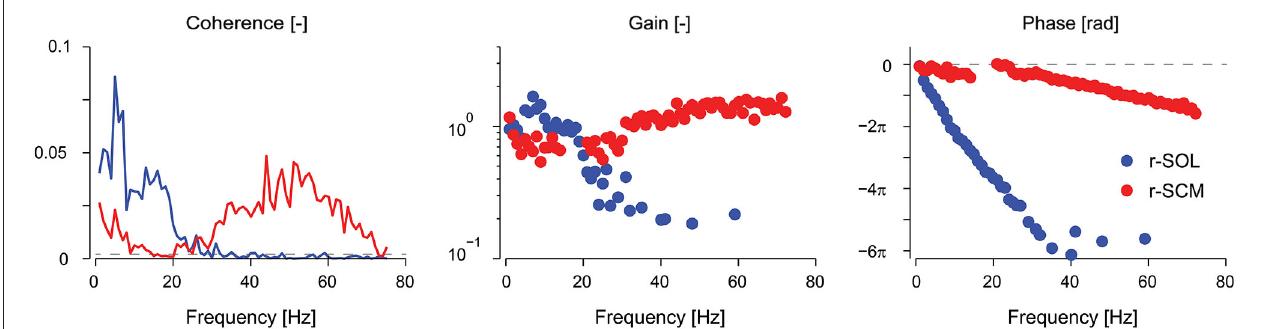
horizontal, segmented line in the coherence plot represents the level above which the coherence is significant. The horizontal, segmented line in the phase plot represents a phase of zero. r-SCM, right sternocleidomastoid; r-SOL, right soleus. (Data are adapted from Forbes et al.,